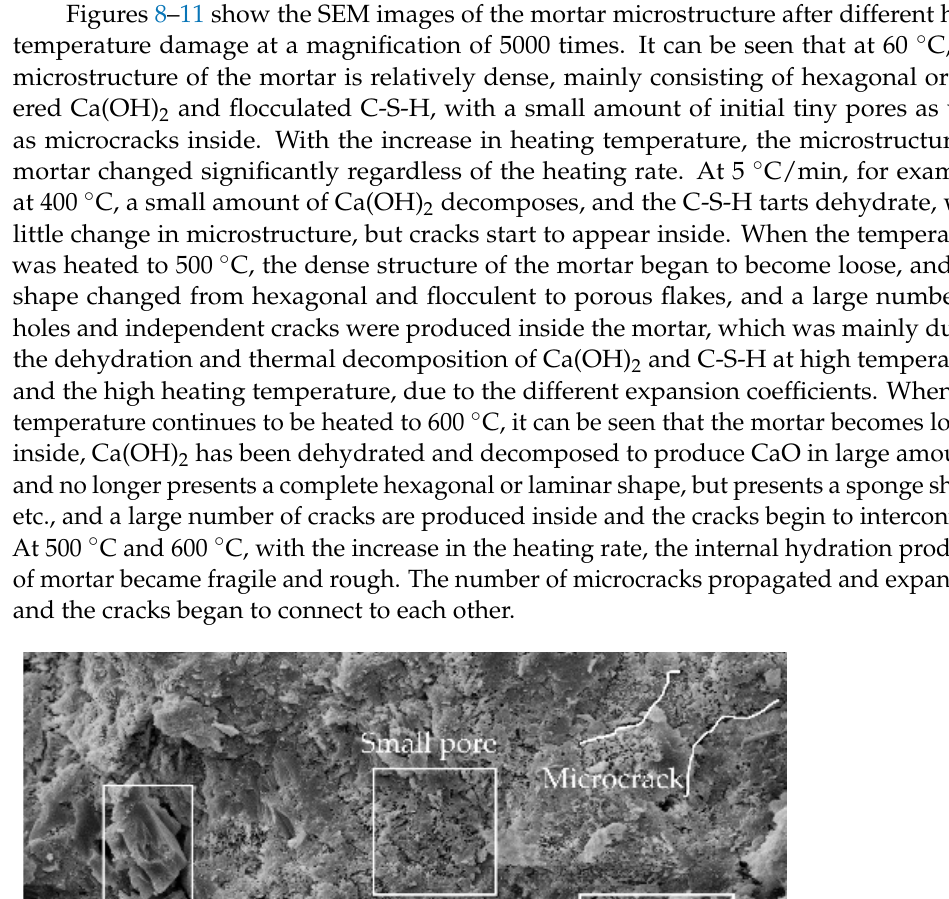
( c ) 15 °C/min ( c ) 15 °C/min Figure 10. Microtopography and pore structure images of mortar heated (500 °C): ( a ) 5 °C/min; ( b ) 10 °C/min; ( c ) 15 °C/min. ( a ) 5 °C/min ( b ) 10 °C/min ( c ) 15 °C/min Figure 11. Microtopography and pore structure images of mortar heated (600 °C): ( a ) 5 °C/min; ( b ) 10 °C/min; ( c ) 15 °C/min. 3.3.2. NMR T 2 Spectra and Fractal Analysis The T 2 relaxation time distributions for mortar are shown in Figure 12. The T 2 spec- trum is positively correlated with the amount of pore water content of concrete, i.e., the